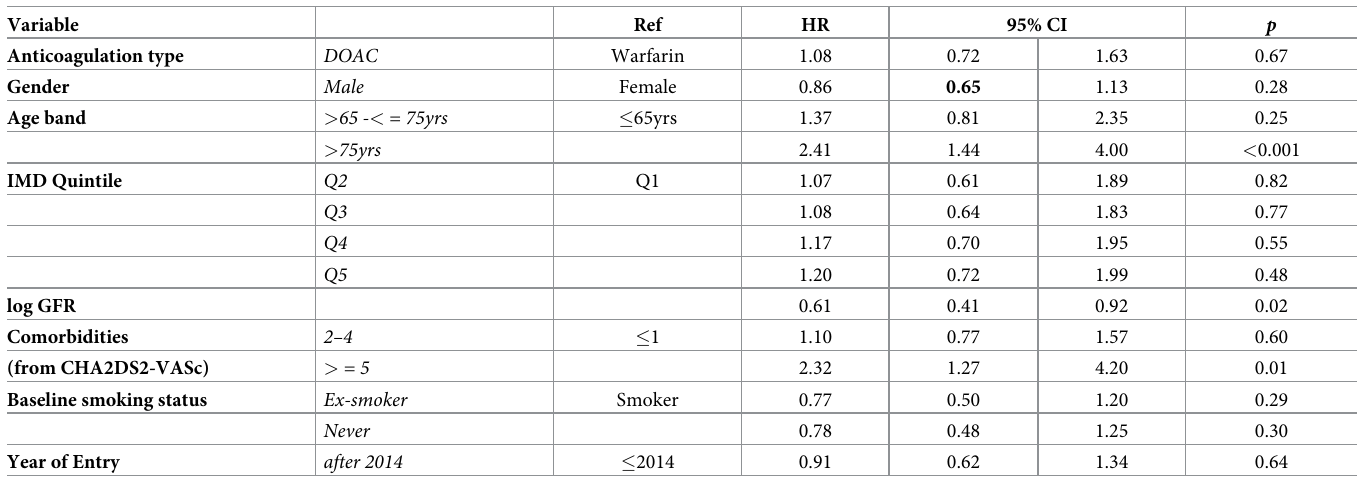
Table 3. Multivariate analysis of the cause-specific hazard ratio (CSHR) for stroke.